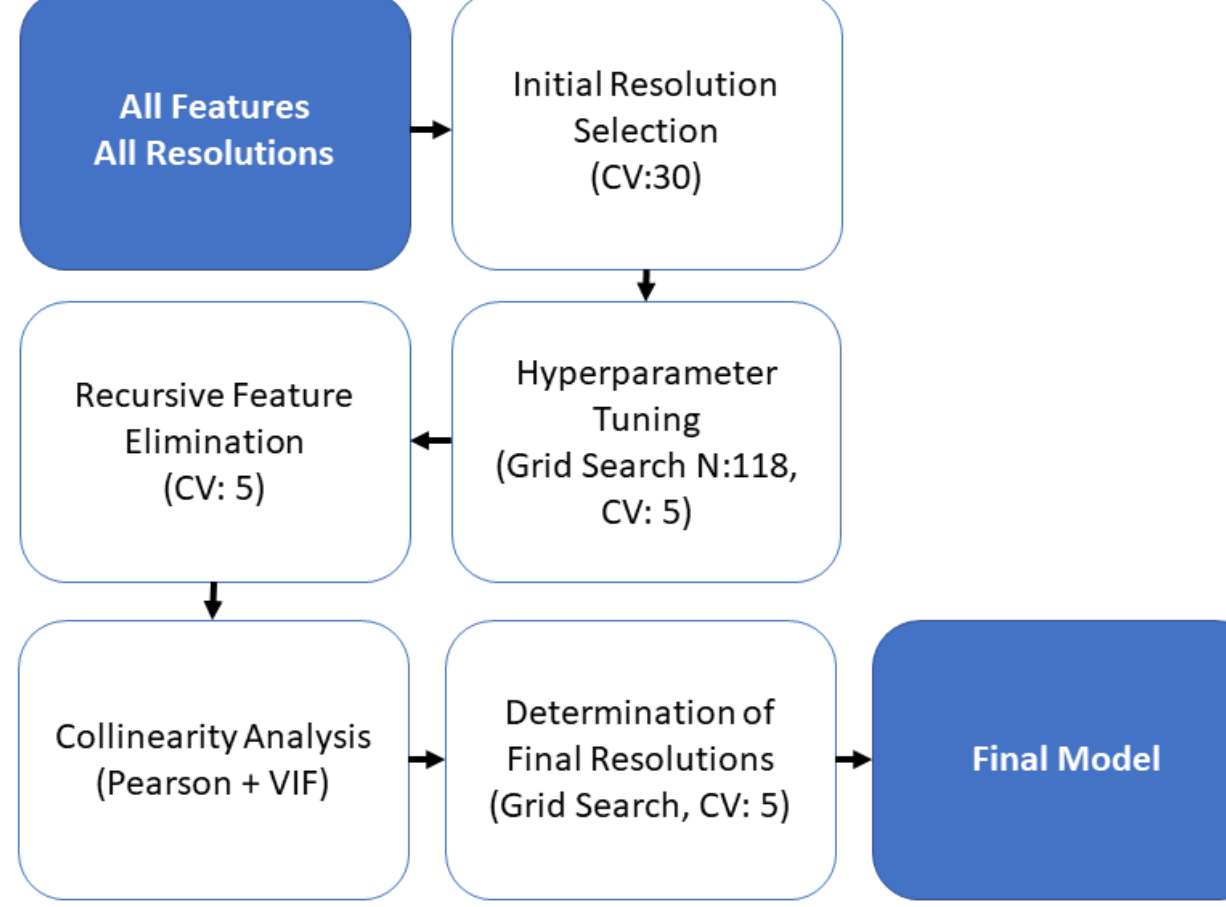
Figure 3. Steps in the fitting procedure to go from using all features and resolutions to a final model for each depth. In parentheses is the method used for each step. CV is the number of cross-validations applied at. N is the number of combinations for the grid search. VIF is the variance inflation factor.